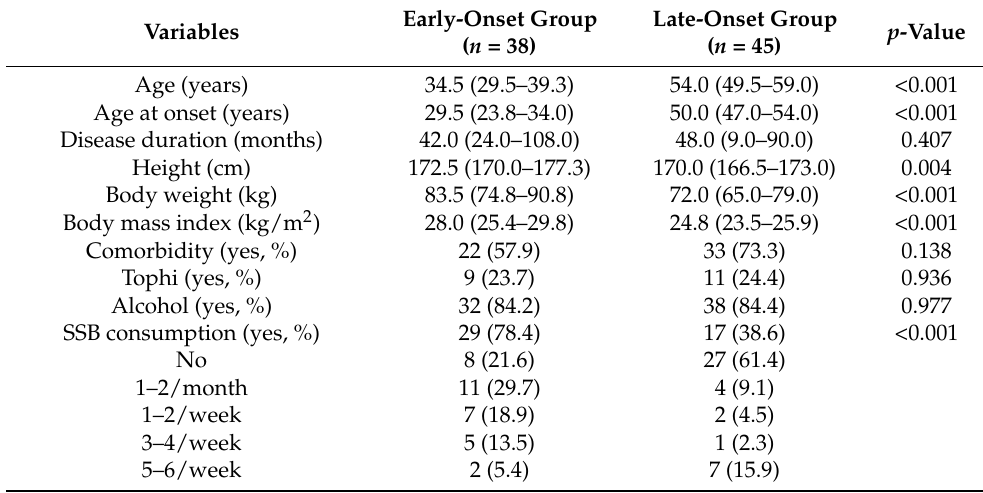
Table 1. Comparison of clinical features between the early-onset and late-onset gout